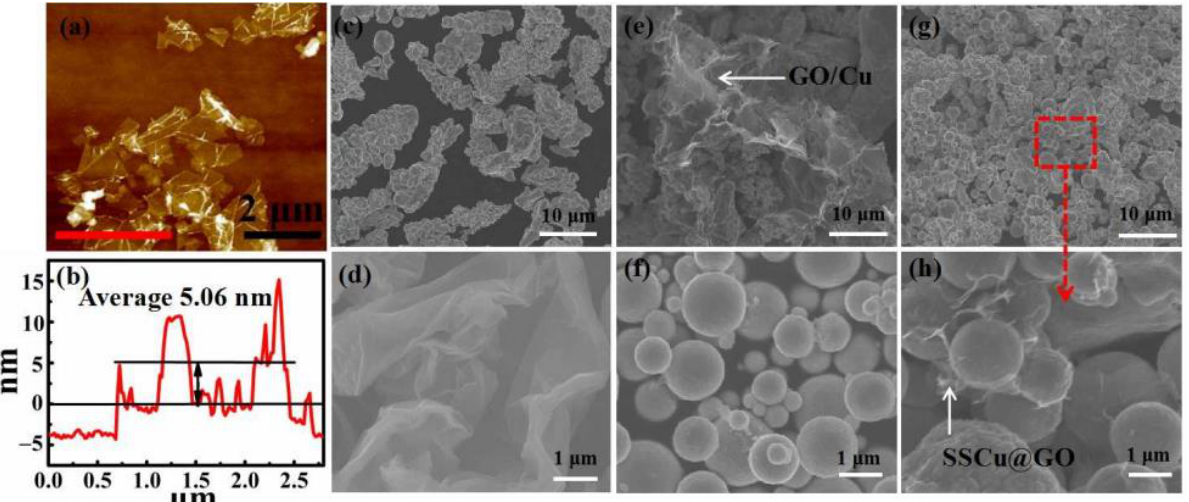
Figure 3. ( a ) AFM image of GO. ( b ) Thickness along the red line in panel ( a ). SEM image of ( c ) Cu, ( d ) GO, ( e ) the GO/Cu composite powder, ( f ) SSCu, and ( g ) the SSCu@GO/Cu composite powder. ( h ) Magnified view of the area surrounded by the red box in panel ( g ).